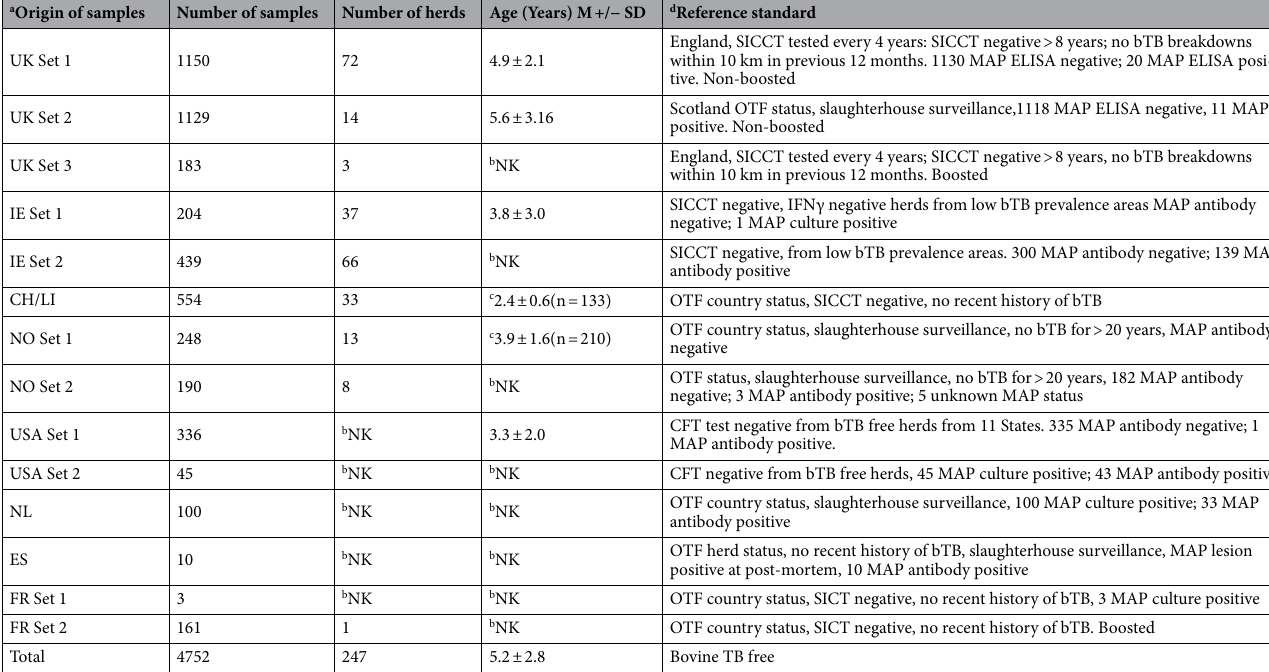
Table 1. Summary of negative reference serum samples. a Serum samples were obtained from bTB free herds in the United Kingdom (UK), Ireland (IE), Switzerland/Liechtenstein (CH/LI), Norway (NO), United States of America (USA), Netherlands (NL), Spain (ES) and France (FR). b Not known; c Age data not complete (number of animals); d SICCT test (UK, IE, CH/LE); CFT test (USA); SICT test (ES, FR); OTF—Officially Tuberculosis Free; MAP— Mycobacterium avium subsp.